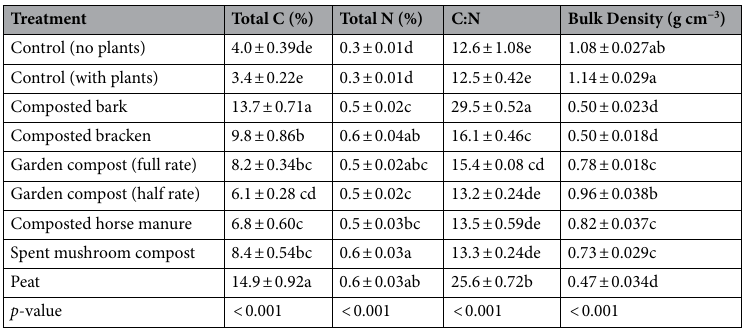
Table 2. Dry density and proportional C content of amended soil after six annual applications (Year 6). Mean of eight replicate experimental plots in Year 6 (n = 8); ± standard error. Treatments that share a subscript letter, for a particular variable, have no significant difference according to one-way ANOVA and Tukeys post-hoc testing ( p > 0.05).